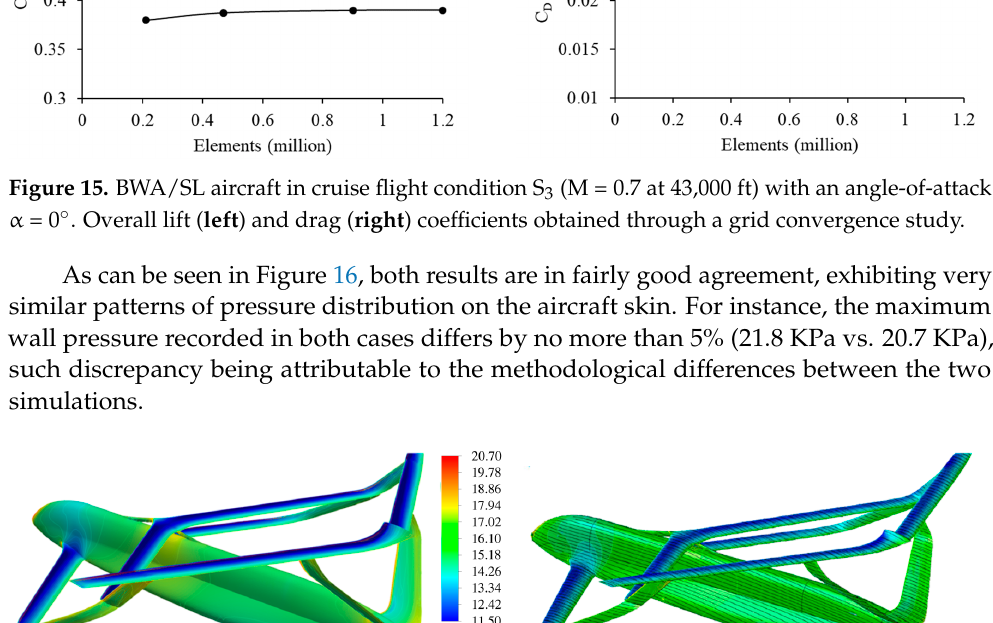
15 of 24 Figure 14. BWA/SL aircraft in various flight conditions. ( Left ): Steady pressure (C p coefficient) on and around the aircraft in cruise flight condition S 3 (M = 0.7 at 43,000 ft) with an angle-of-attack α = 0°. ( Right ): L/D values obtained for the various flight conditions and aerodynamic settings ( α ). On the right side of the same Figure 14, the computational outputs associated with all flight conditions are plotted in terms of the resulting lift-to-drag ratio (L/D). It appears that the aerodynamic performance of BWA/SL is rather independent of the altitude, while varying more importantly with the airspeed (M) and the aerodynamic settings ( α ). The best aerodynamic performance is reached under the S 3 flight condition (M = 0.7 at 43,000 ft), with an L/D value of 15.5 ~16 (under an angle of attack of zero or slightly negative value). Notably, this L/D ratio is very similar to that of a Boeing B747-400 in cruise [49],